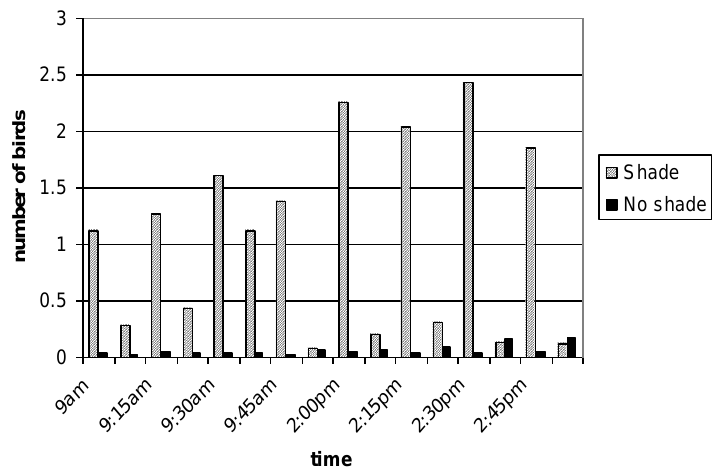
Figure 3. Average number of birds in shelterbelt shade and non shade areas over a day